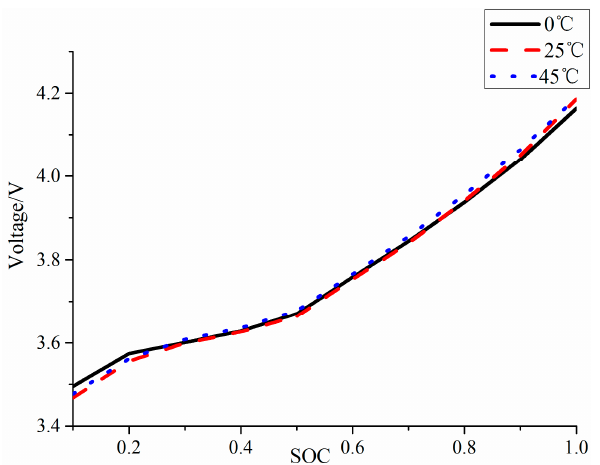
Figure 3. The relation diagram of open-circuit voltage (OCV)–state of charge (SOC) at different temperatures.